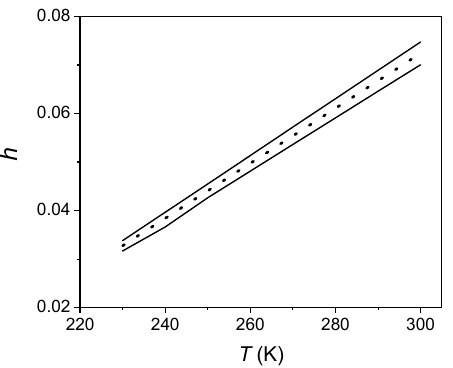
Figure 2. Behaviour of the free volume fraction in S3 (dotted line) as predicted by the lattice hole model. Continuous lines: uncertainties on h .